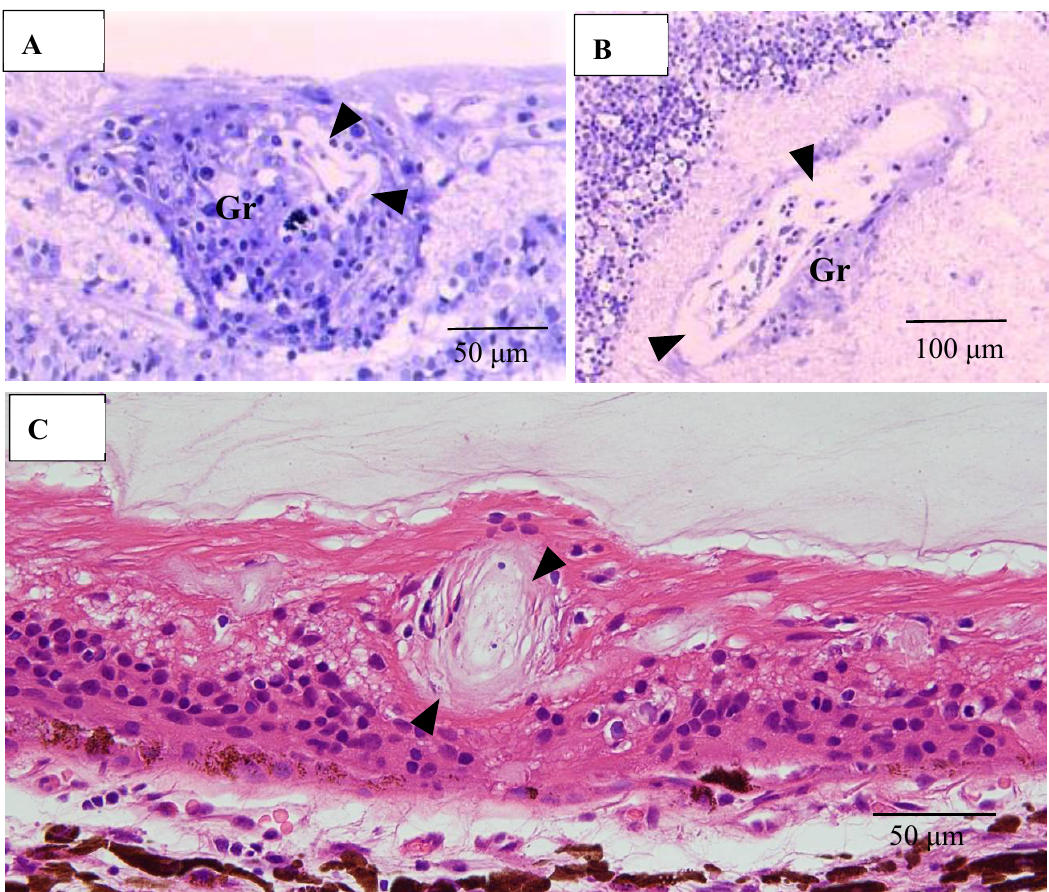
Figure 13. ( A – C ) Light microscopy photographs of retinal vein in ordinal ( A , C ) and tangential sections ( B ) of the left eye of Autopsy Case 1, a 75-year-old female. ( A , B ) Methylmethacrylate embedding, toluidine blue stain. ( C ) Paraffin